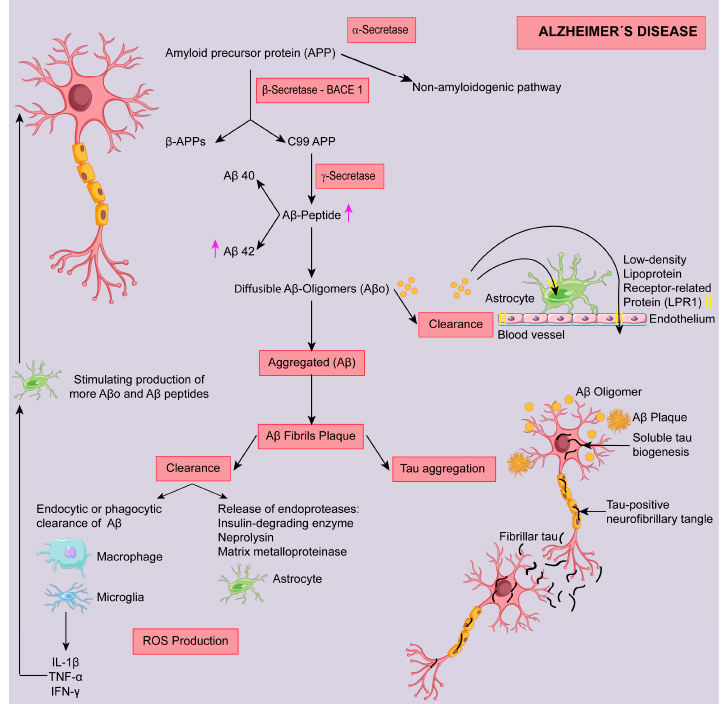
Figure 2. Diagrammatic representation of pathogenic mechanisms involved in Alzheimer’s disease. A β , amyloid beta; A β o, amyloid beta oligomers; APP, amyloid precursor protein; IL-1 β , interleukin 1 beta; IFN- γ , interferon gamma; LPR1, low-density lipoprotein receptor-related protein 1; ROS, reactive oxygen species; TNF- α , tumor necrosis factor